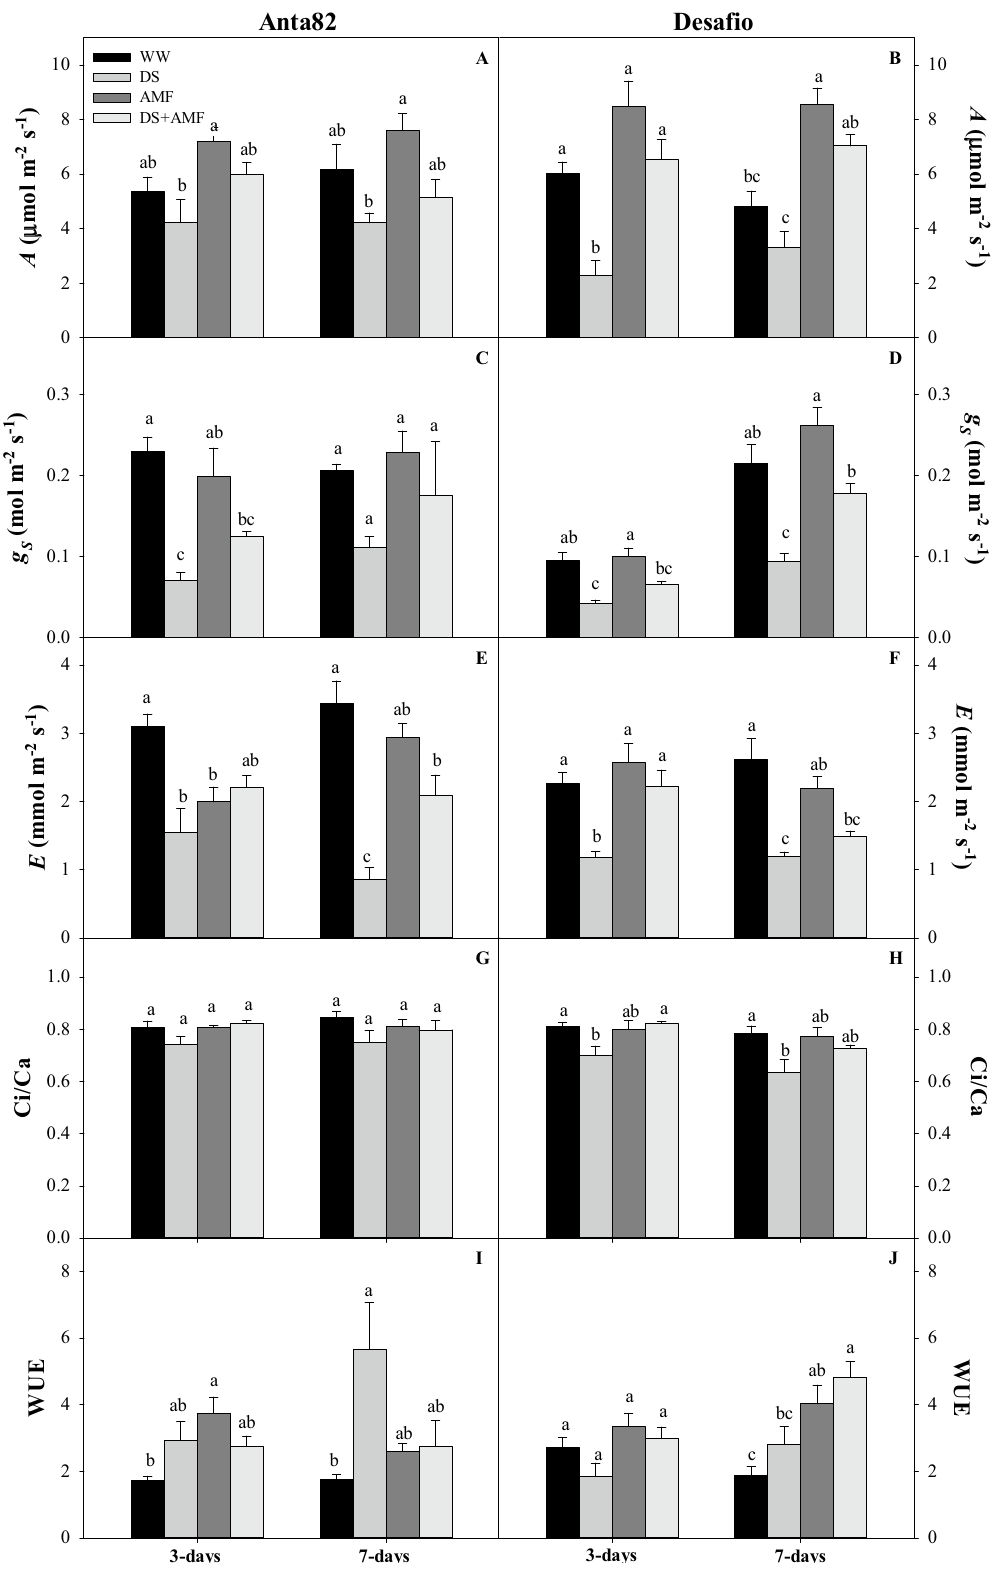
Figure 4. Photosynthetic rate ( A ), stomatal conductance ( g S ), transpiration ( E ), the ratio between internal and external CO 2 concentrations (C i /C a ), and water use efficiency (WUE) on days 3 and 7 in the ( A , C , E , G , I ) Anta82 and ( B , D , F , H , J ) Desafio soybean cultivars under different conditions of inoculation and water stress. WW = well-watered, noninoculated, DS = drought stress, noninoculated, WW + AMF = well-watered and inoculated, DS + AMF = drought stress and inoculated. The bars represent the mean ± SEM ( n = 4). Pairs of means in the same period (3 or 7 days) with different letters are significantly different ( p < 0.05) based on Tukey’s post hoc